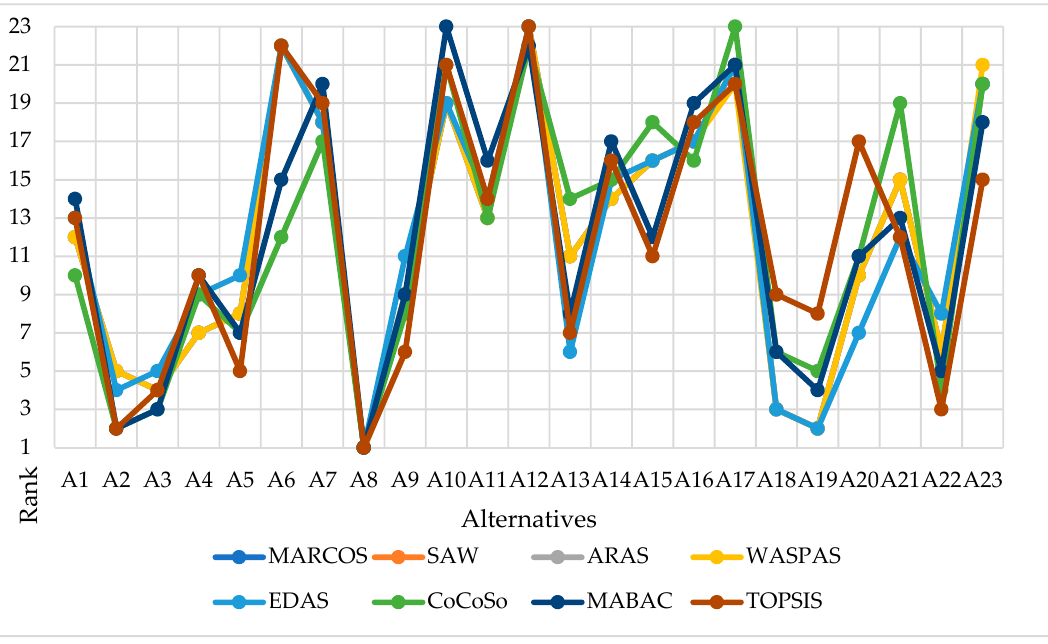
Figure 3. Results of sensitivity analysis using different MCDM methods.